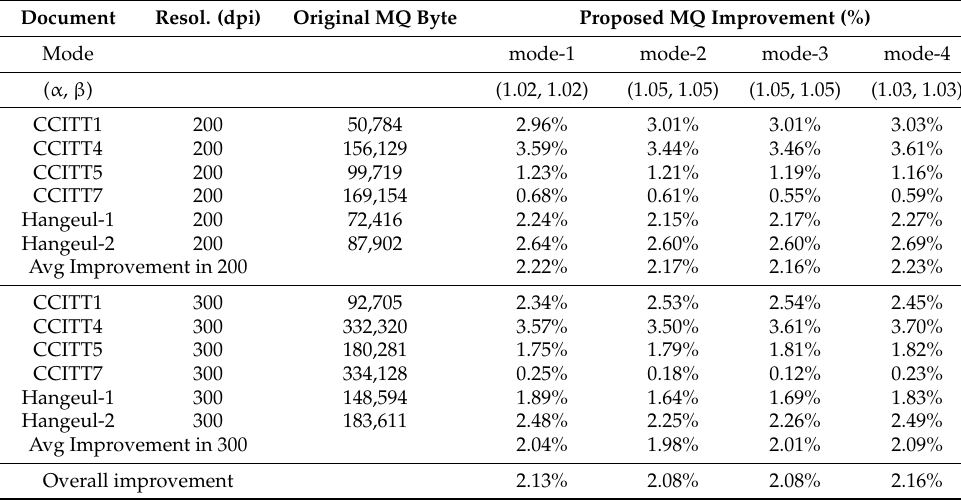
Table 12. Experimental Results for each mode using 4-level LUT for binary